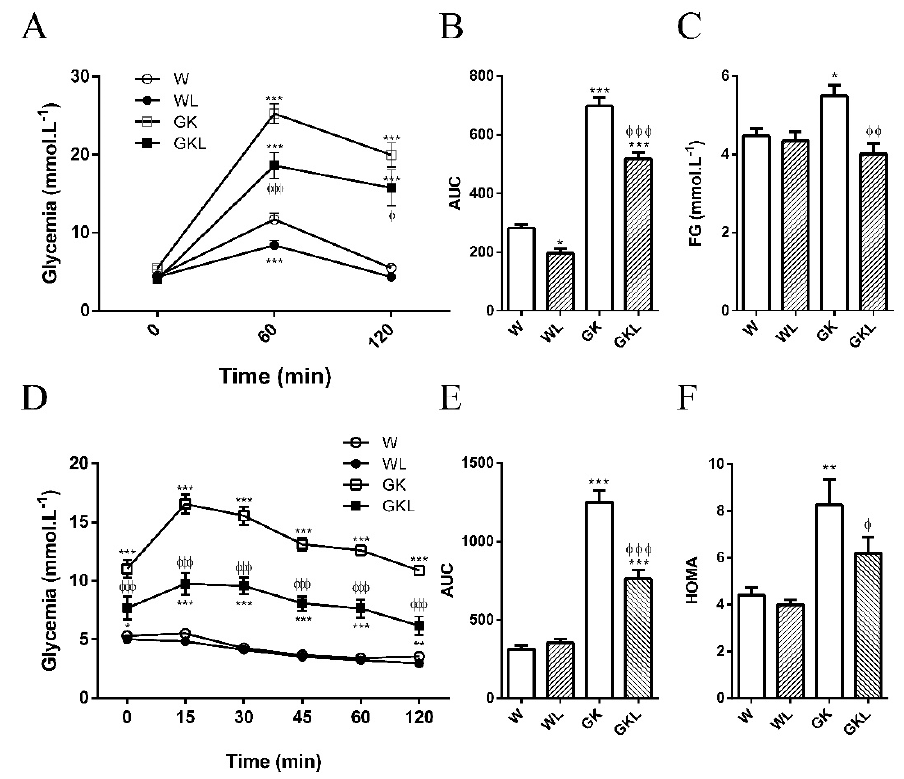
Figure 1. Influence of luteolin on blood glucose levels throughout an intraperitoneal glucose tolerance test (IPGTT; ( A )), the glucose area under the curve (AUC; ( B )), fasting glycemia ( C ), insulin tolerance test (ITT; D ), the insulin area under the curve (AUC; ( E )), and homeostasis model assessment of insulin resistance (HOMA, ( F )) in normal Wistar (W), diabetic Goto-Kakizaki (GK) control rats and rats treated with luteolin (10 mg/kg/day, orally) for 2 months (WL, GKL). Data are expressed as mean ± SE ( n = 10). * p < 0.05, ** p < 0.01, *** p < 0.001 vs. W group; φ p < 0.05, φφ p < 0.01, φφφ p < 0.001 vs. GK group.